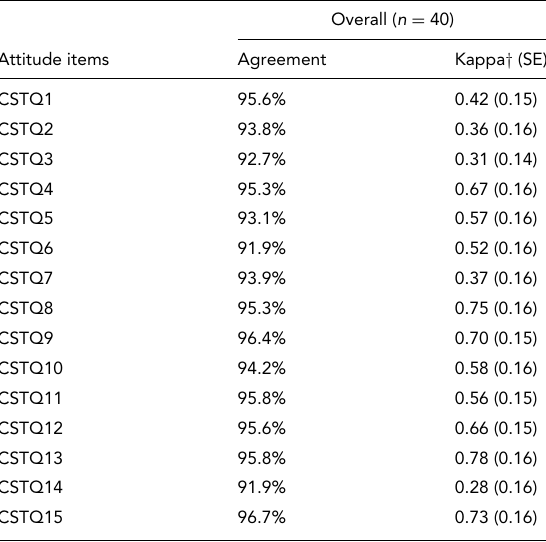
Test–Retest Reliability of